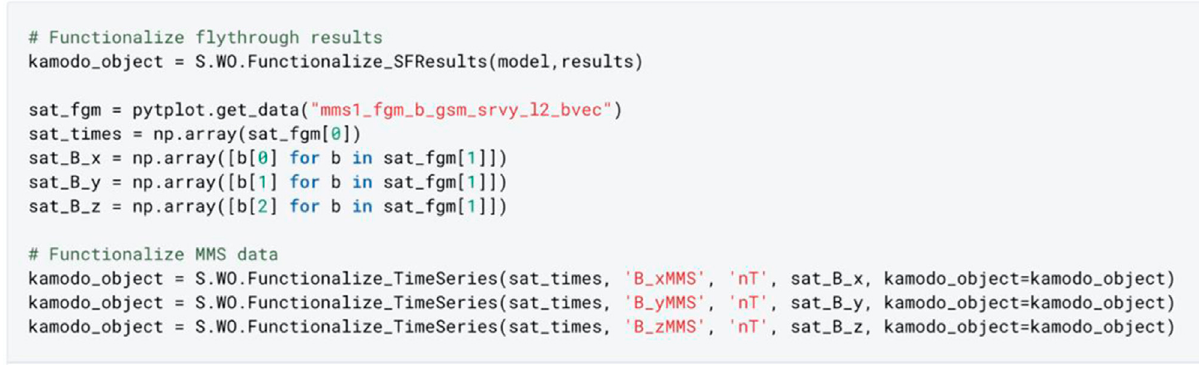
Frontiers in Astronomy and Space